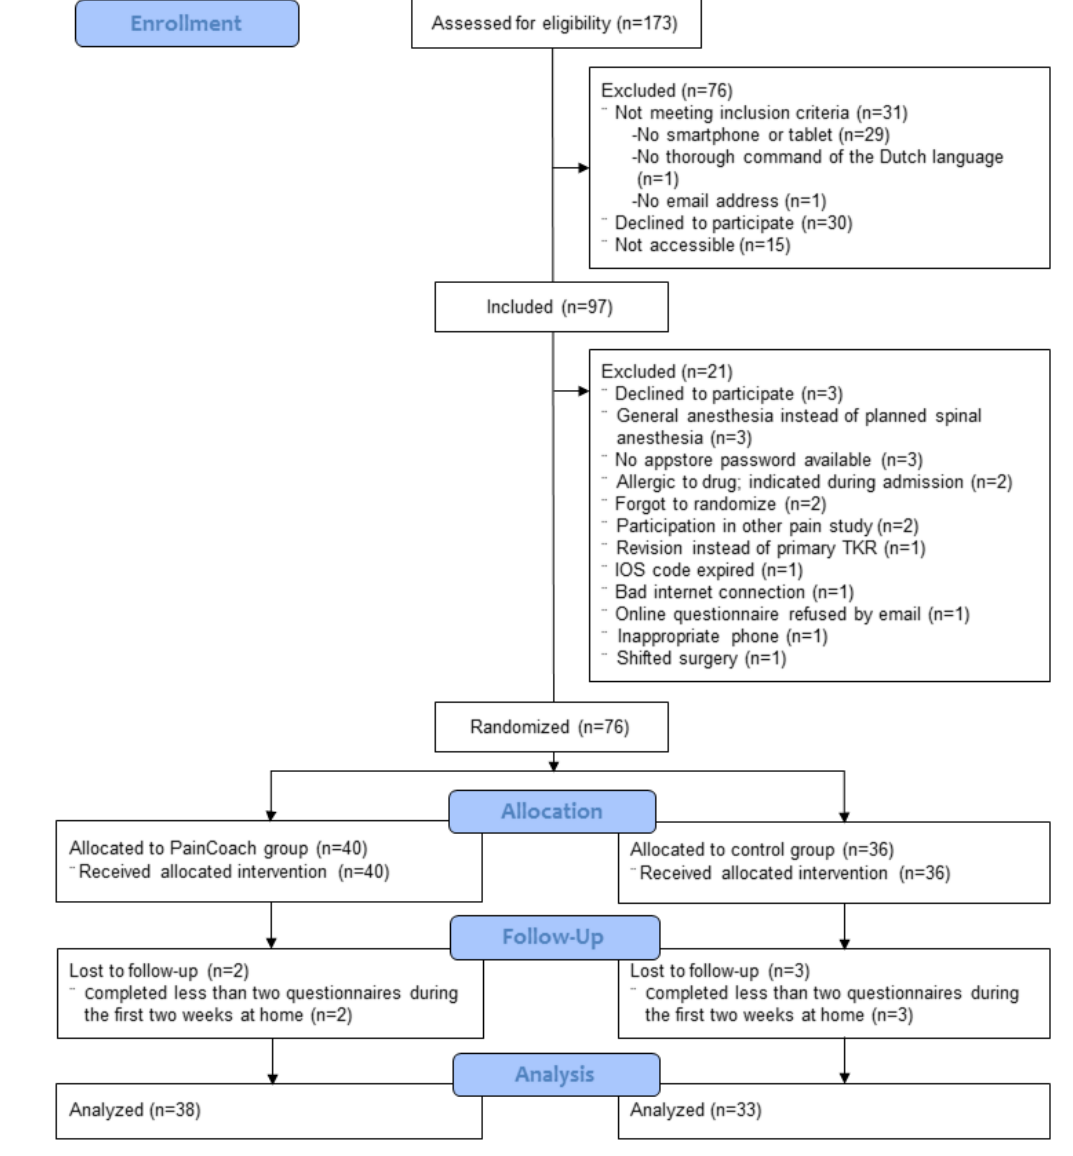
Figure 1. Study flowchart. IOS: iPhone operating system; TKR: total knee